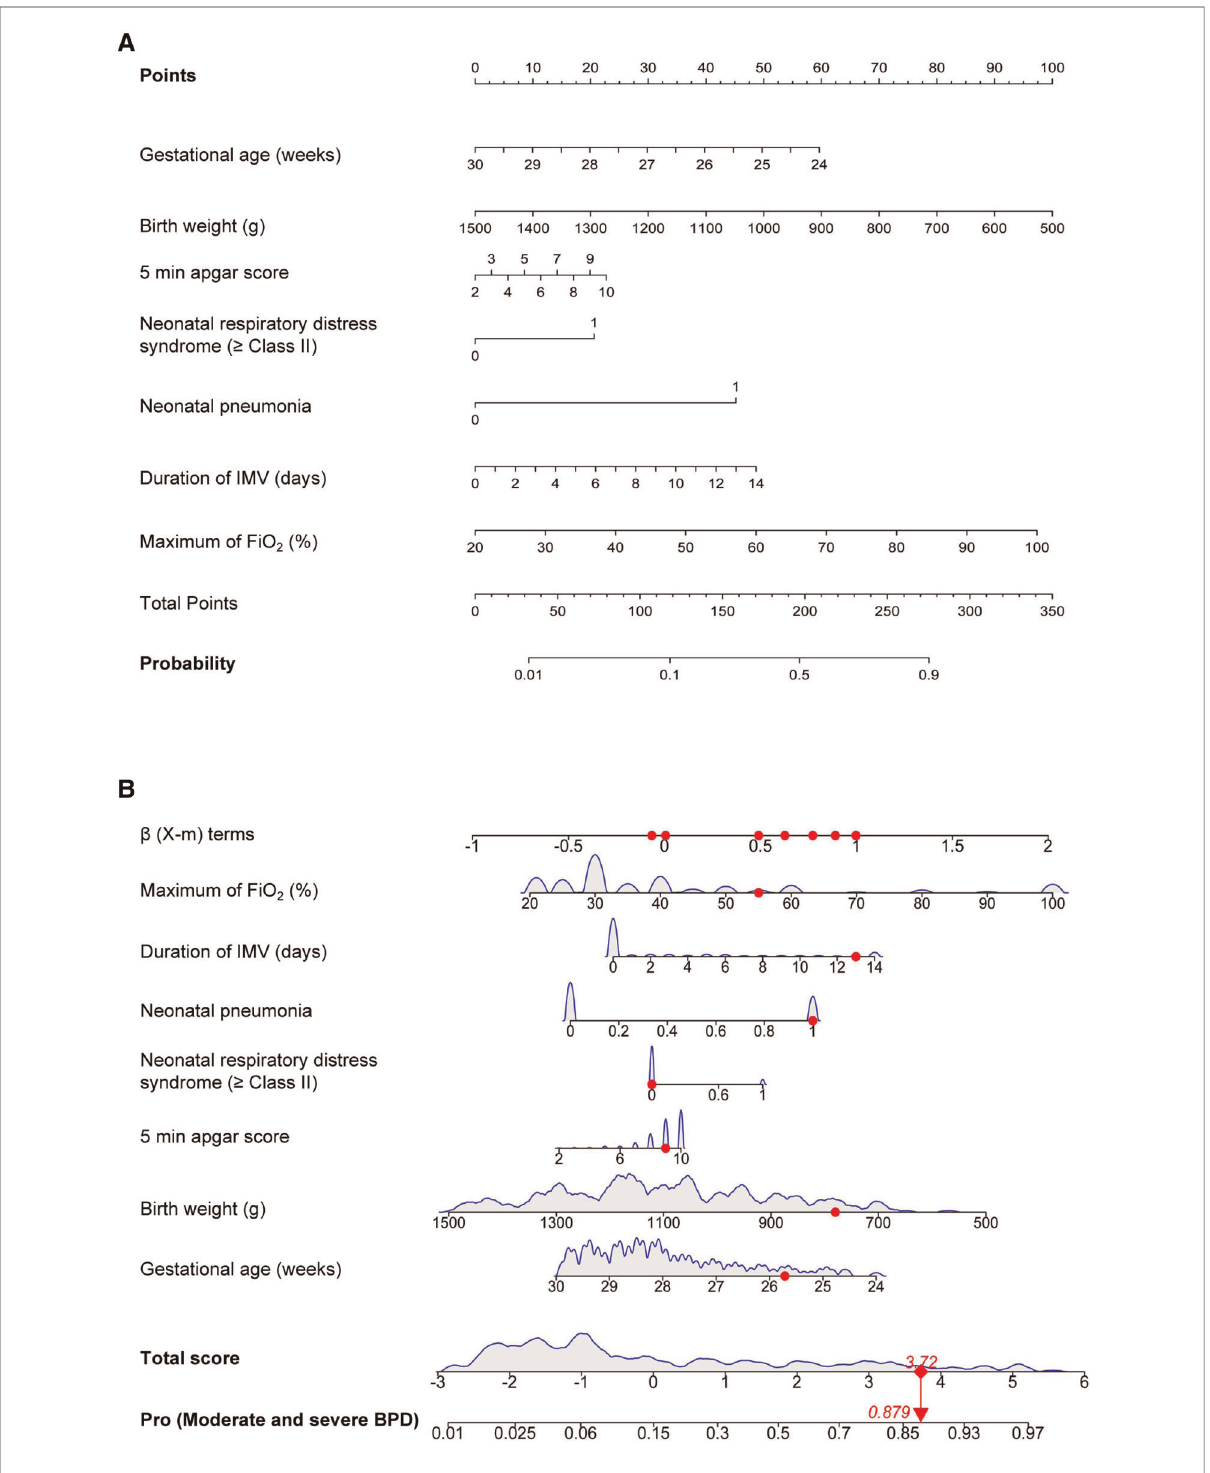
FIGURE 3 Moderate and severe BPD risk nomogram prediction model. ( A ) Risk factors of gestational age, birth weight, 5 min apgar score, neonatal respiratory distress syndrome ( ≥ Class II), neonatal pneumonia, duration of IMV and maximum of FiO 2 for nomogram prediction model. ( B ) Dynamic nomogram used as an example. BPD, bronchopulmonary dysplasia; IMV, invasive mechanical ventilation; FiO 2 , fraction of inspiration O 2